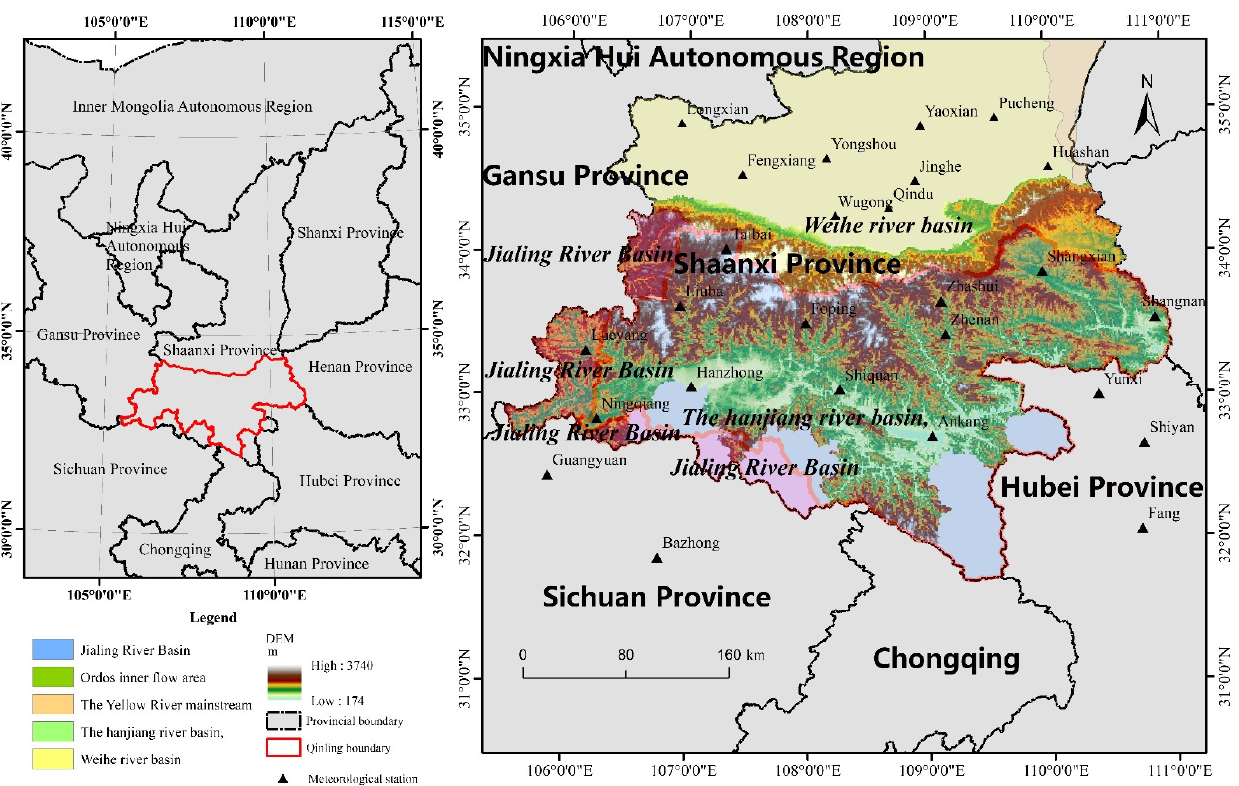
Figure 1. Overview of the study area.